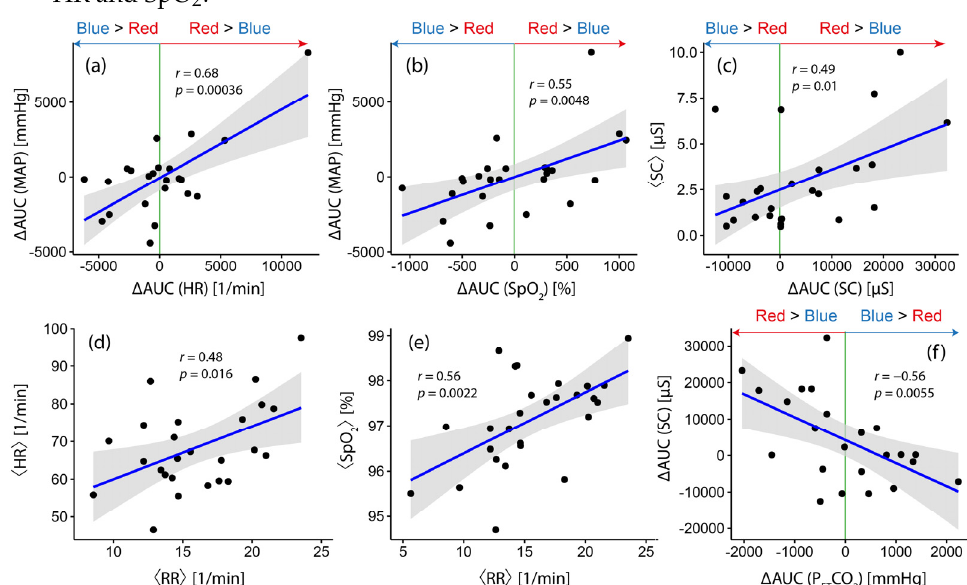
Figure 4. Correlations between ∆ AUC values of systemic physiological signals. Results of linear correlation analysis. The gray shaded areas refer to the confidence bounds of the determined correlation.